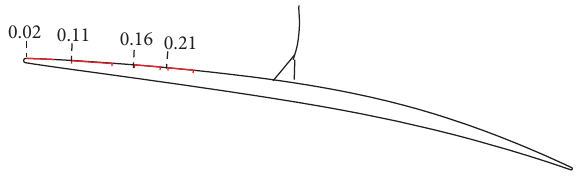
Figure 3: Turbulator strip locations on the blade.